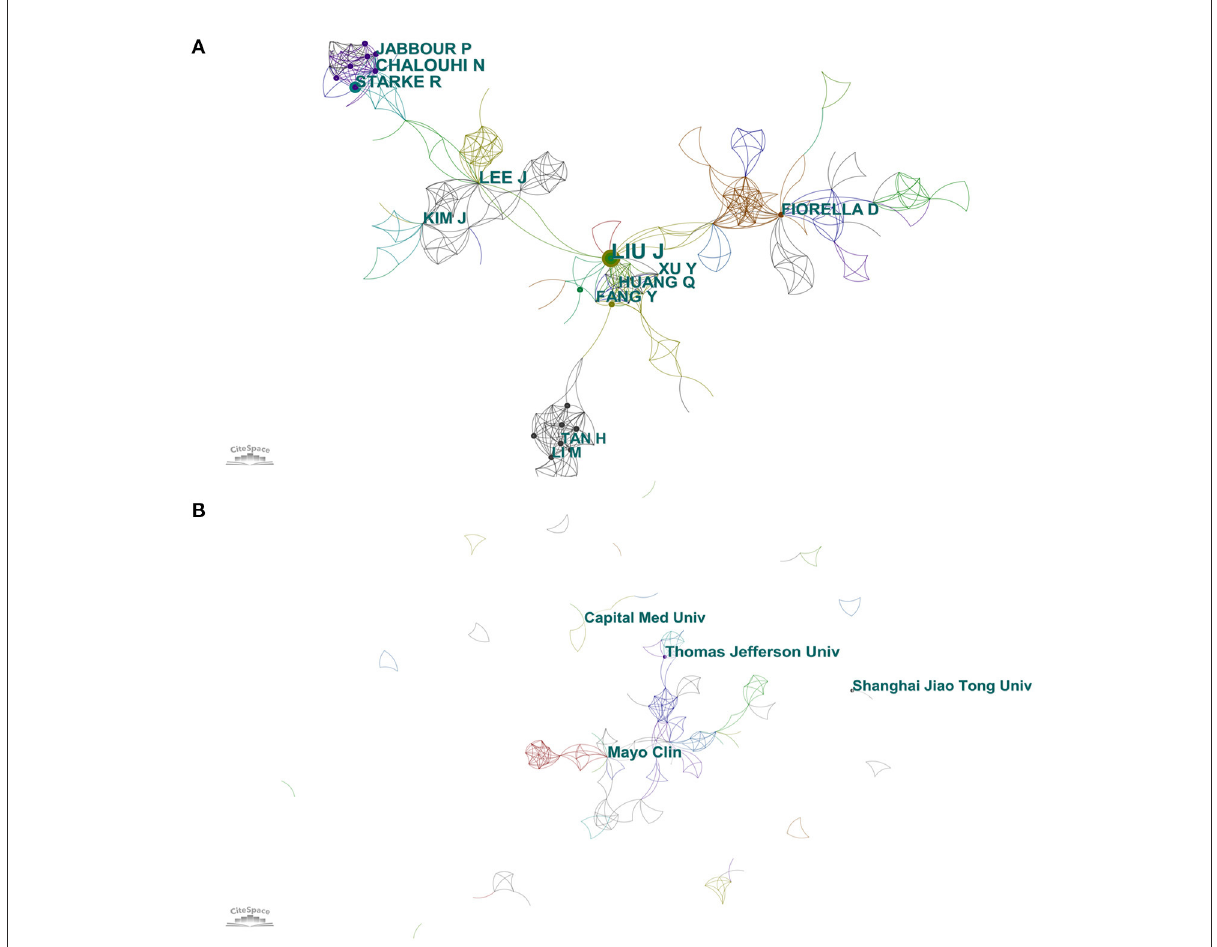
FIGURE5 (A) Author cooperation network map. (B) Institution cooperation network